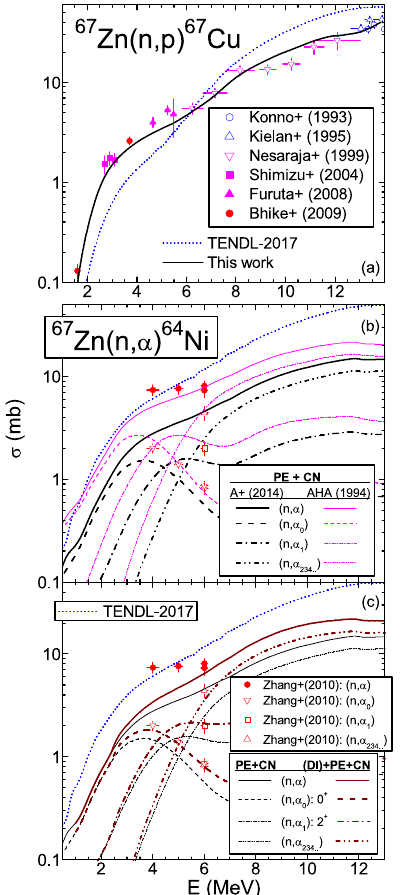
Figure 7. (a,b) As Fig. 5 but for 67 Zn( n , x ), and (c) as Fig. 3 but for 67 Zn( n ,α ) 64 Ni reactions, including partial components